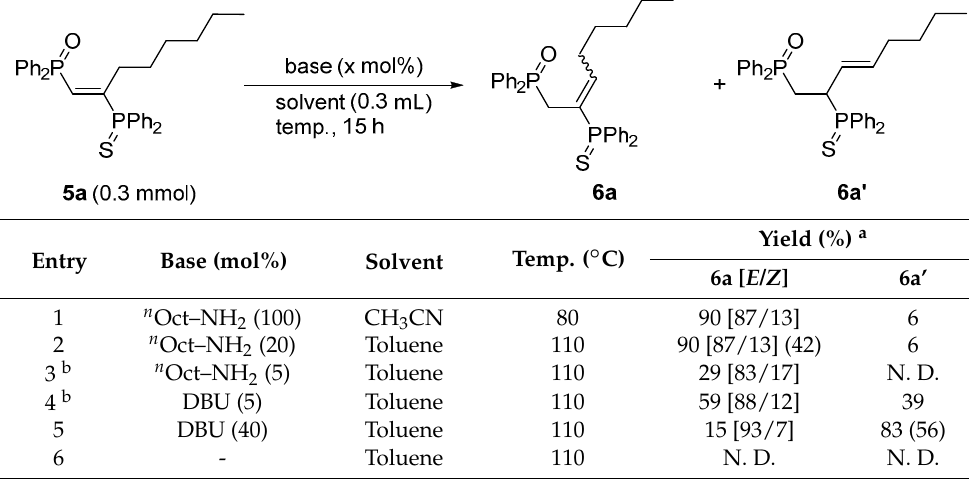
Table 4. Optimization of the reaction conditions for the base-catalyzed double-bond isomerization of 5a .